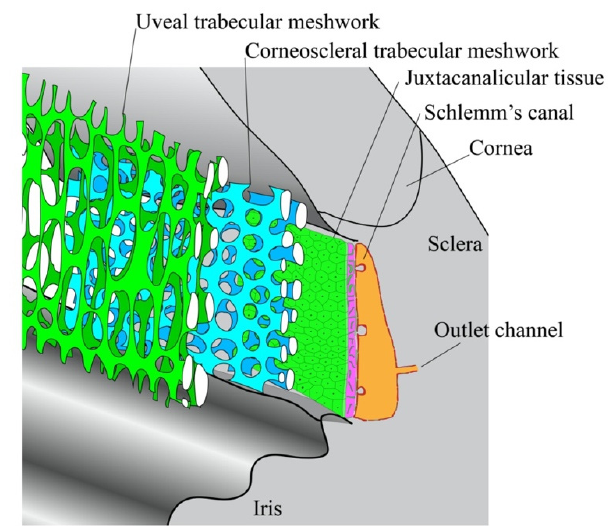
Figure 2. Substructures of trabecular meshwork and Schlemm’s canal.